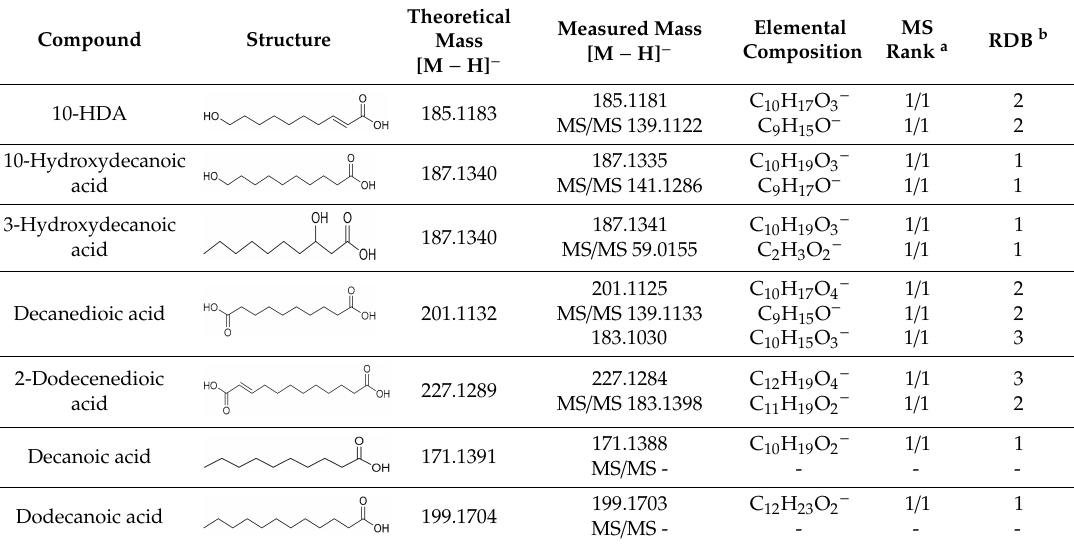
Table 1. Fatty acids used in the chromatographic method and mass spectral